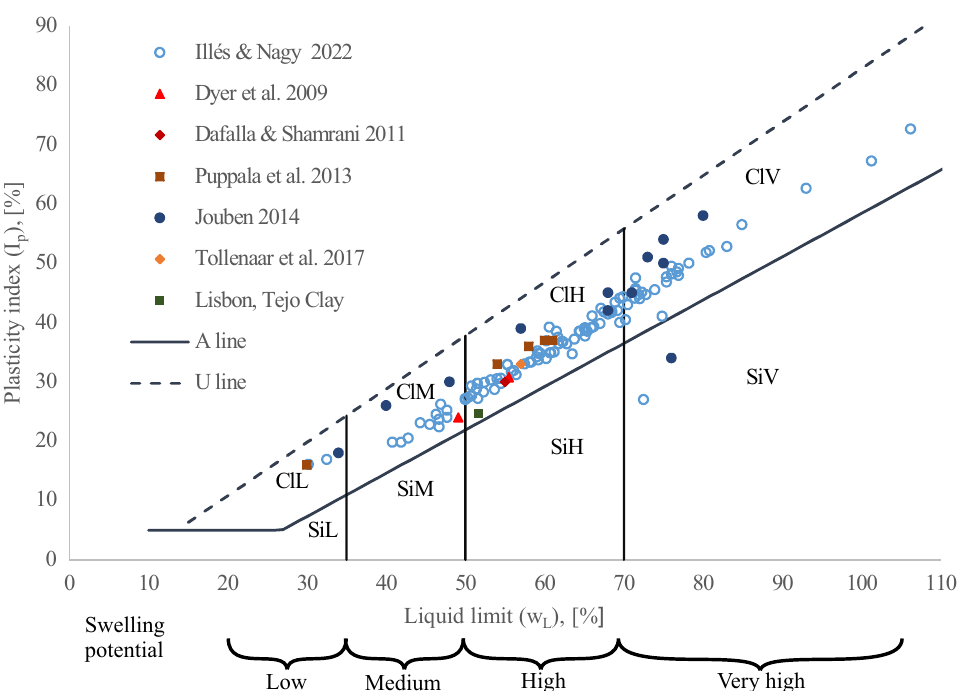
Fig. 11 Plasticity chart after Casagrande, according to ISO 14688-2:2017, samples from investigations: Dyer et al. 2009; Dafalla and Shamrani 2011; Puppala et al. 2013; Jouben 2014; Tollenaar et al. 2017, are marked